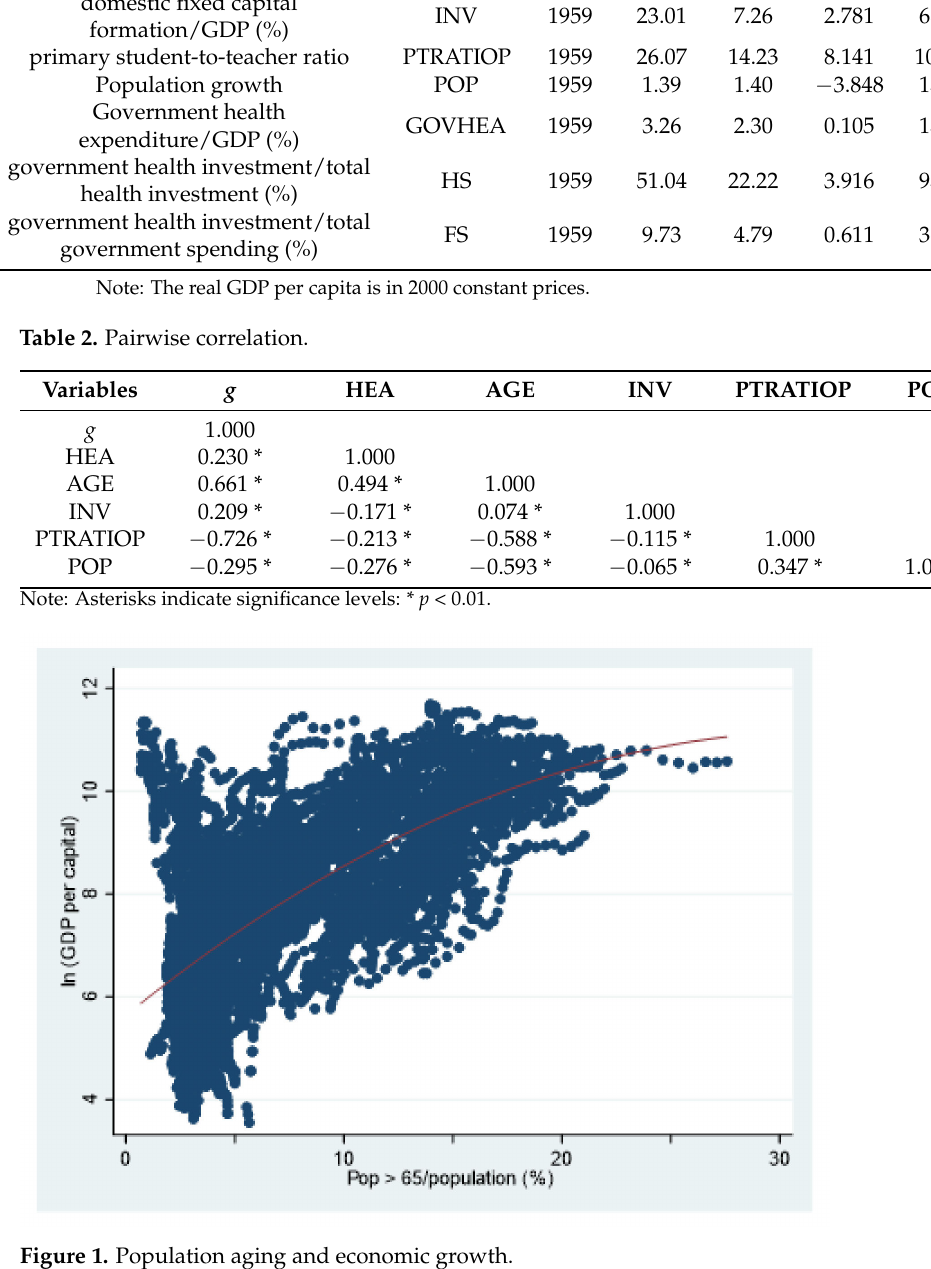
Figure 1. Population aging and economic